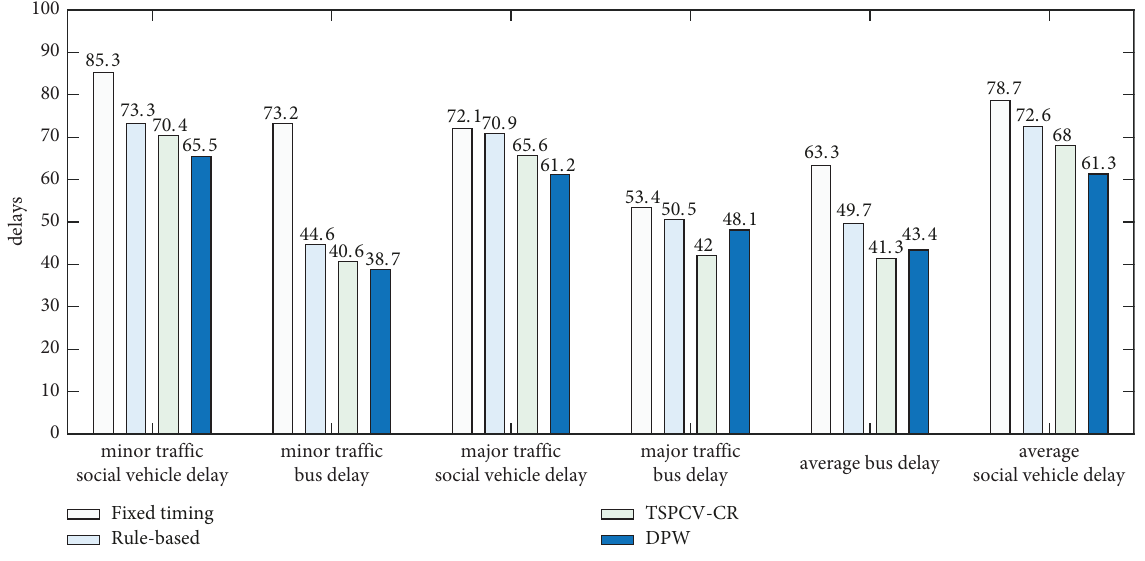
Figure 8: Delay comparison among fxed timing, TSPCV-CR, and DPW signal control